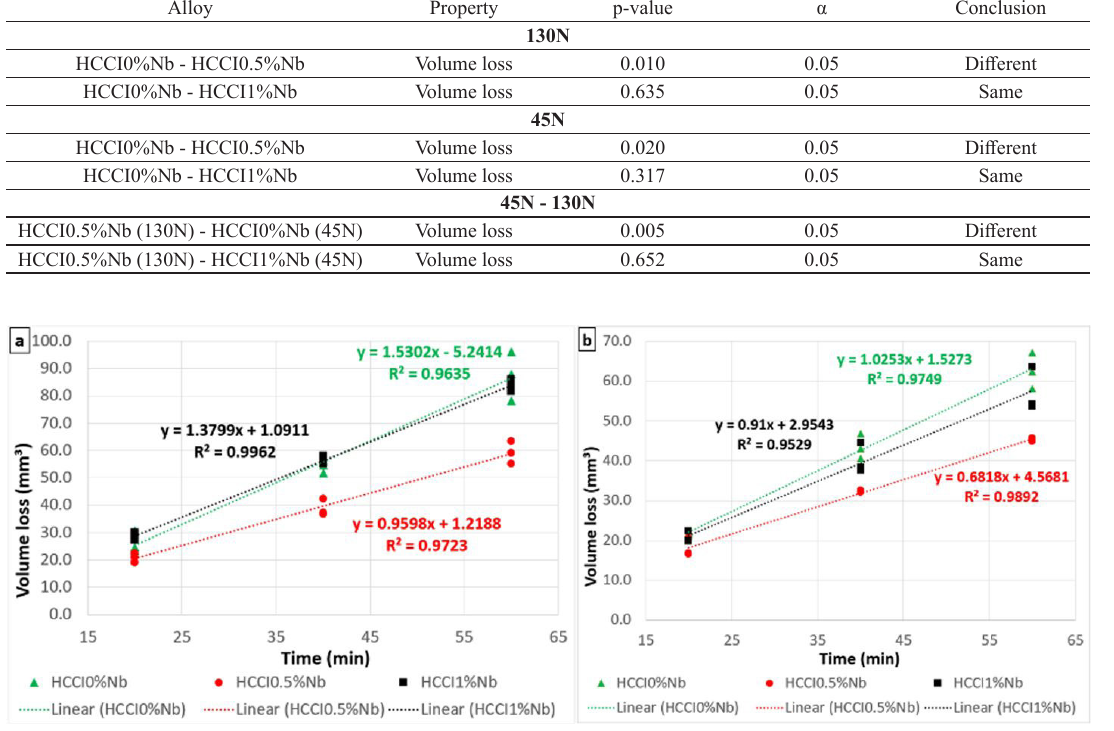
Figure 11. Volume loss curves as a function of time (a) 130N; (b) 45N.